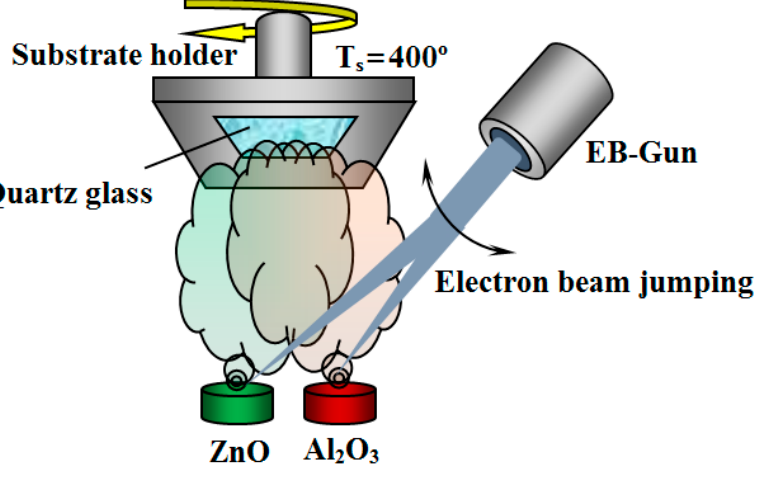
Figure 11. Schematic diagram of dielectric coating deposition by an electron beam [99].